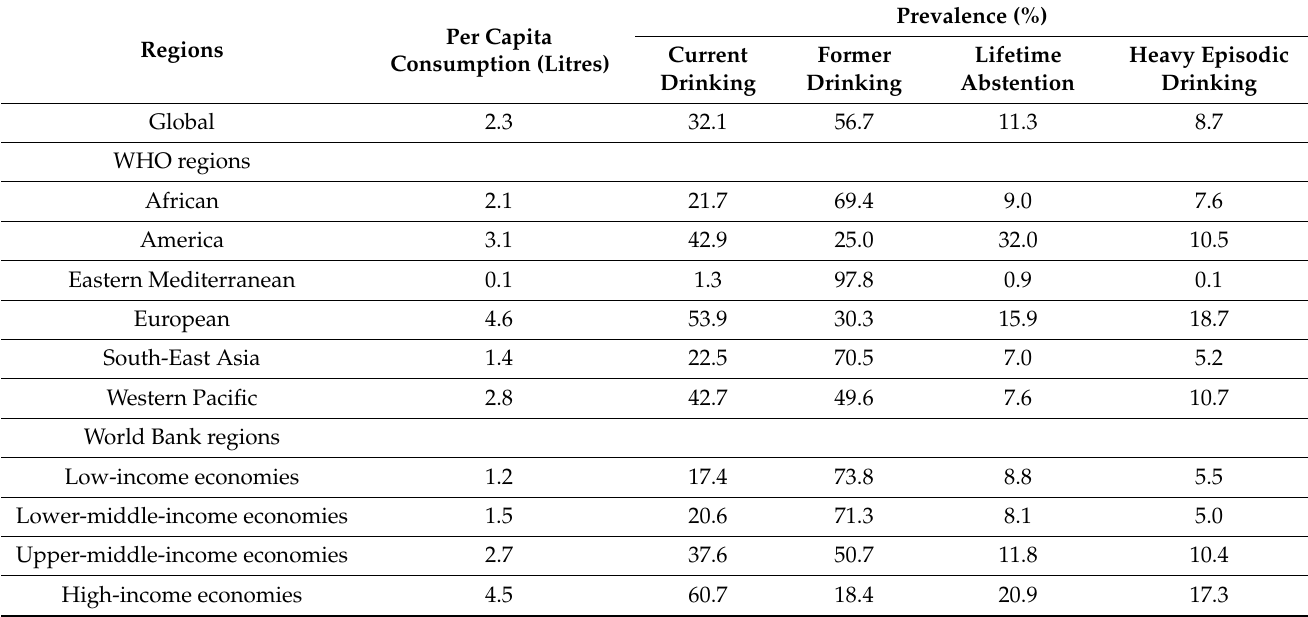
Table 1. Adult per capita consumption and the prevalence of current drinking, former drinking, lifetime abstention, and heavy episodic drinking among women of childbearing age (15 to 49 years of age) in